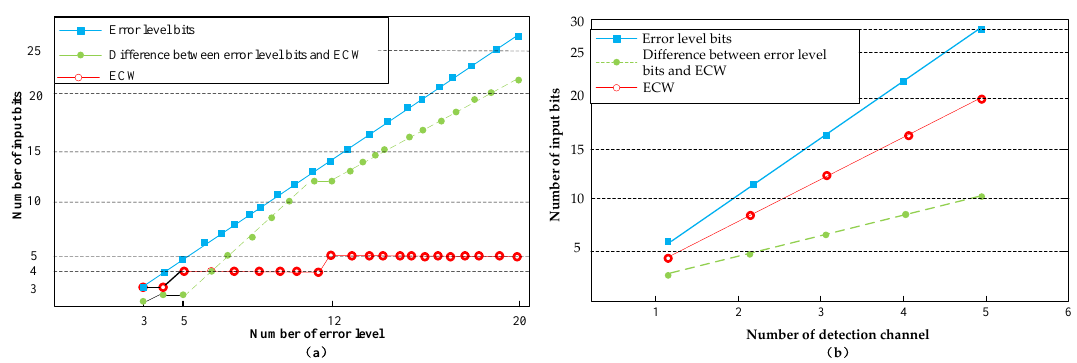
Figure 6. ( a ) Comparison of the number of error levels and coded error data in the channel. ( b ) Increasing tendencies for various